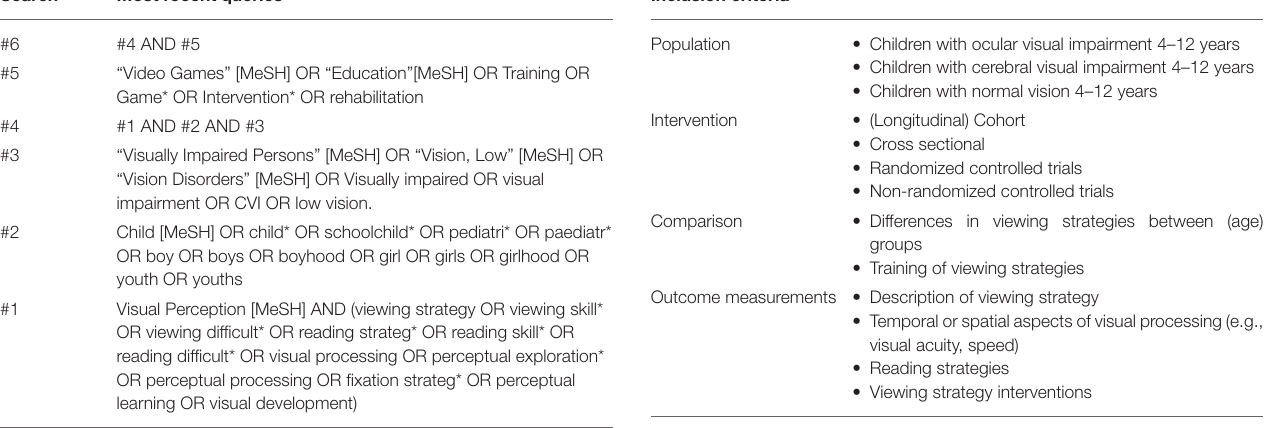
TABLE 1 | Search history in PubMed. Search